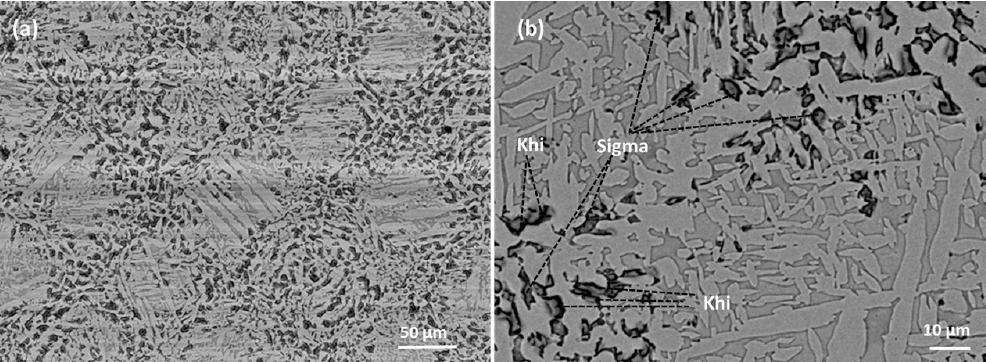
Figure 4. ( a , b ) Back scattered SEM image showing existence of austenite, ferrite and intermetallic sigma and Khi phases. Sigma and Khi phases are shown with arrows in ( b ). sigma and Khi phases. Sigma and Khi phases are shown with arrows in ( b ).